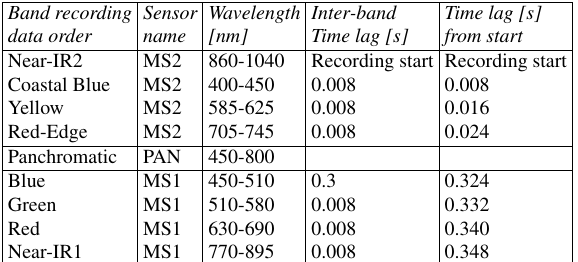
Table 1: WorldView-2’s recording properties Band recording Sensor Wavelength Inter-band